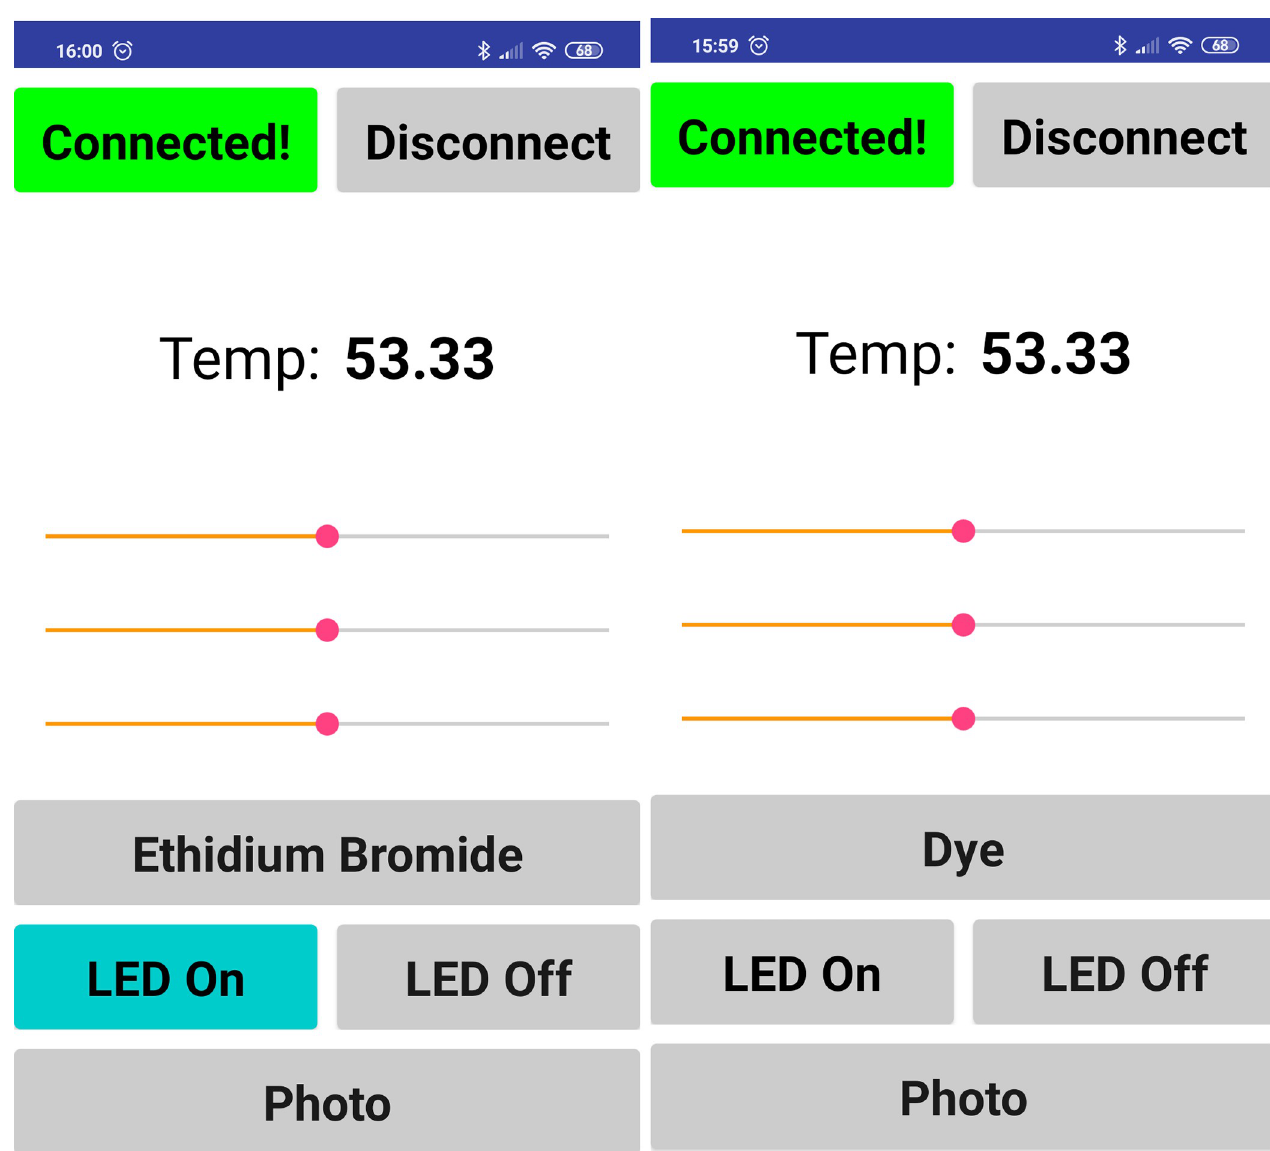
Fig 5. Screenshots of the smartphone software. In the software, it is possible to monitor the device temperature and to make the fine-tune adjustments for dye selection. Initial screen (right). Preset for using ethidium bromide as a dye (left).